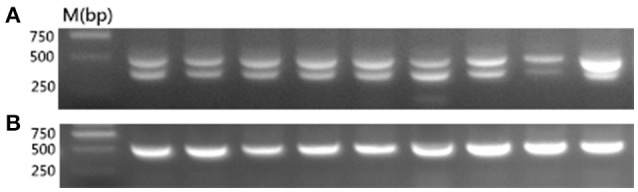
PCR detection for the ev21 assay. (A) Late-feathering chickens produced two amplification bands at about 515 and 390 bp. (B) Fast-feathering chickens produced a single band at about 515 bp. All samples were detected in this study and the results complied with the above figure. Given the limited space available, this figure shows only partial results.